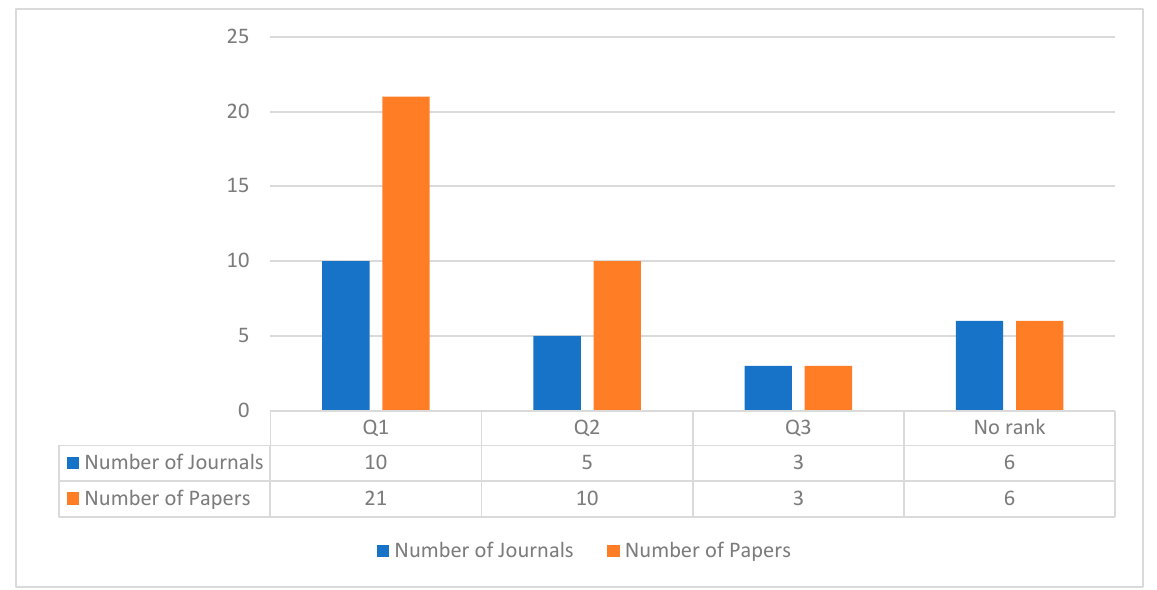
Figure 6. Categorisation of papers using ranking by Journal Impact Factor (JIF) Quartile.